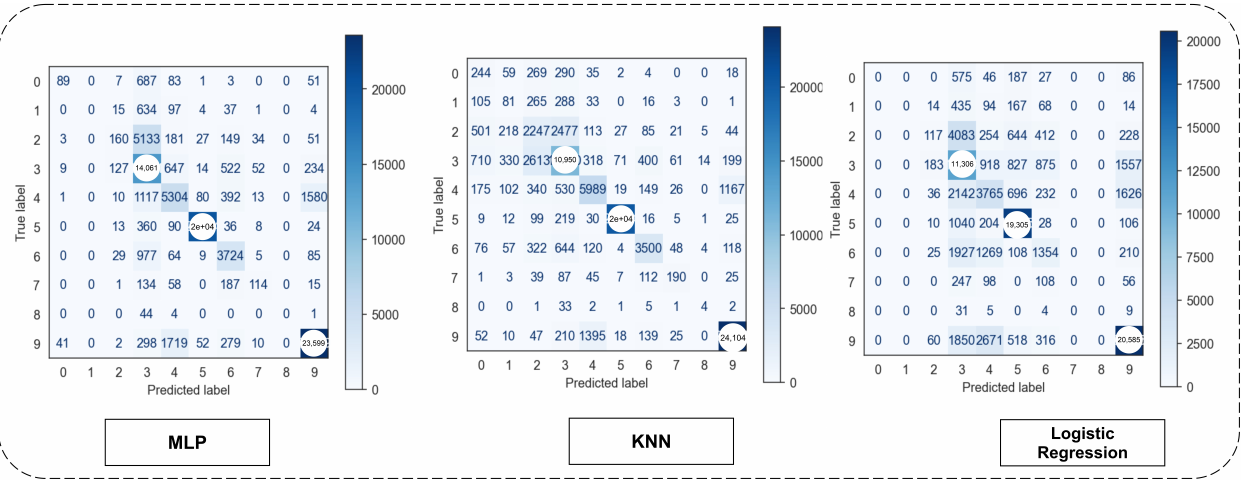
Figure 5. Confusion matrices of multi-class classification on original + GAN-based new dataset (first three